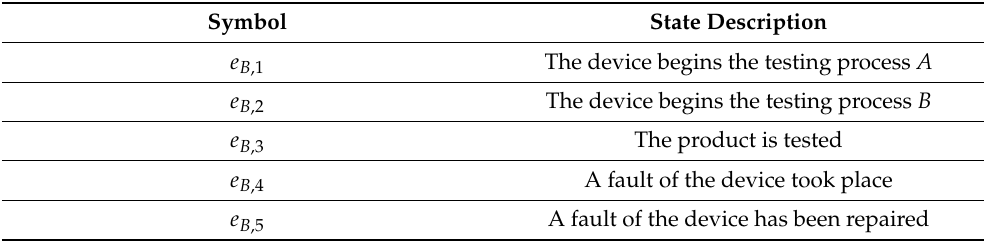
Table 8. Events of the testing device.